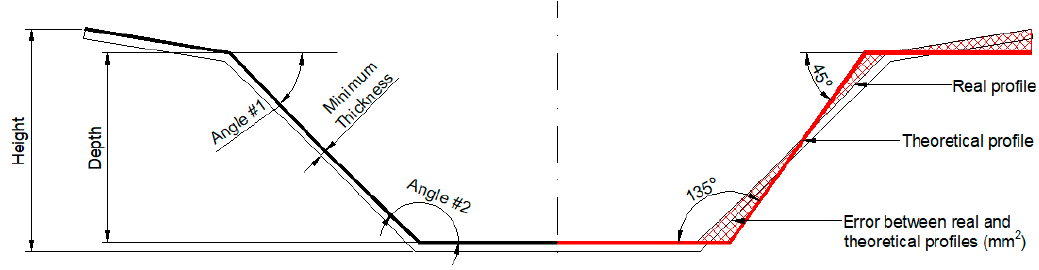
Figure 4. Geometrical characterization of the part and error respect to theoretical profile.